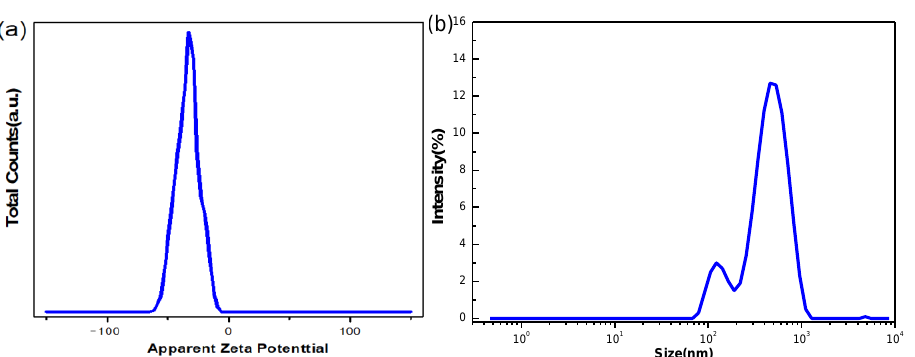
Figure 3. ( a ) Zeta potential of 0.002% GO nanofluid and ( b ) particle size distribution intensity curve of 0.002% GO nanofluid.